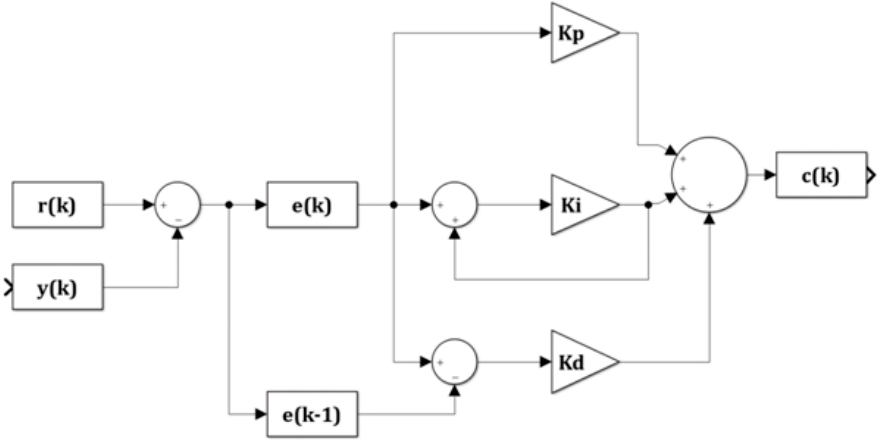
Figure 2. Block diagram of each PID controller.